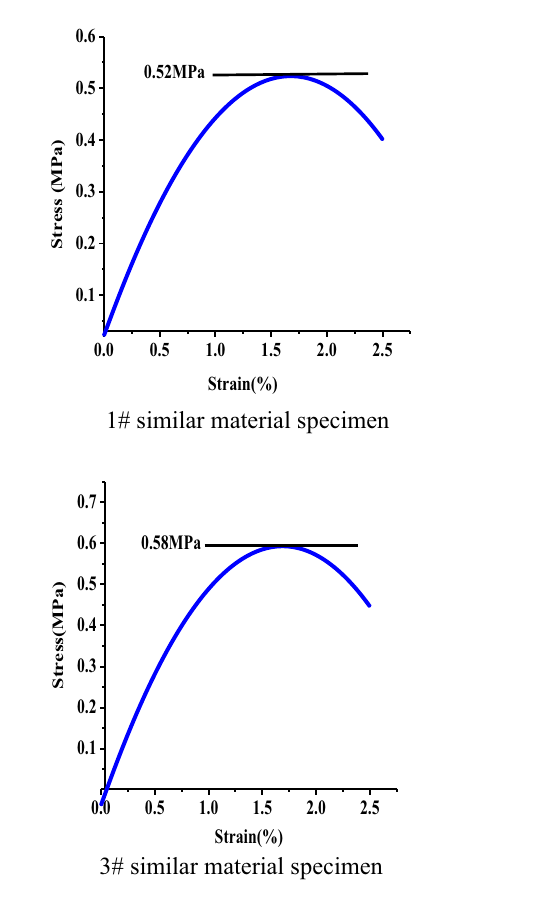
Fig. 6 Typical stress–strain curve of similar materials